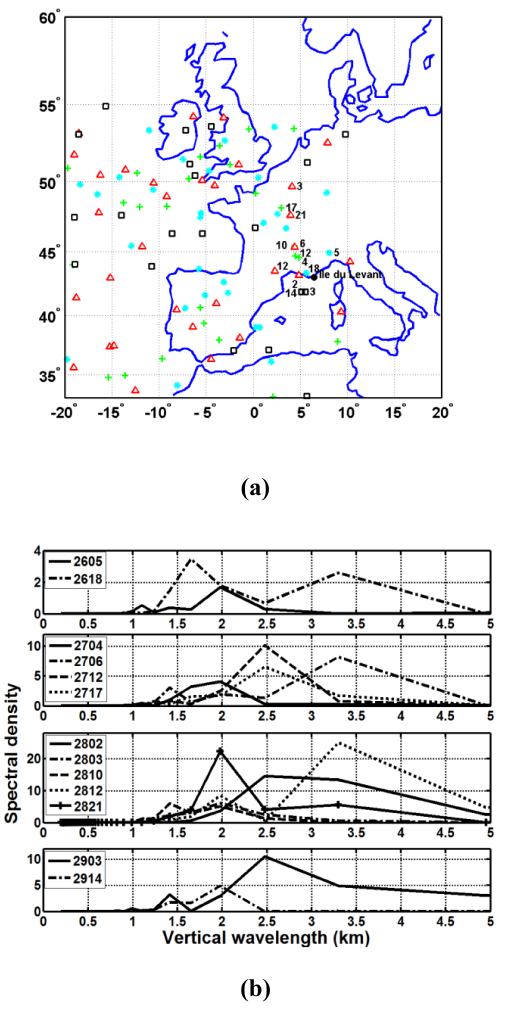
Figure 6. (a) Location of GPS-RO COSMIC data on 26, 27, 28, and 29 July 2013 marked with ∗ , + , triangle, square symbols respec- tively. The black dot locates Ile du Levant. Numbers near markers indicate hours (UTC) of profiles from which (b) spectral densities ( ◦ C 2 km − 1 ) of GPS-RO temperature perturbations ( ◦ C) are calcu- lated for modes with vertical wavelengths < 5km at altitudes of 10–20km at heights of 10–20km at longitudes of 2.5–6 ◦ E and lat- itudes of 40–50 ◦ N on 26, 27, 28, and 29 July 2013 (upper panel to lower